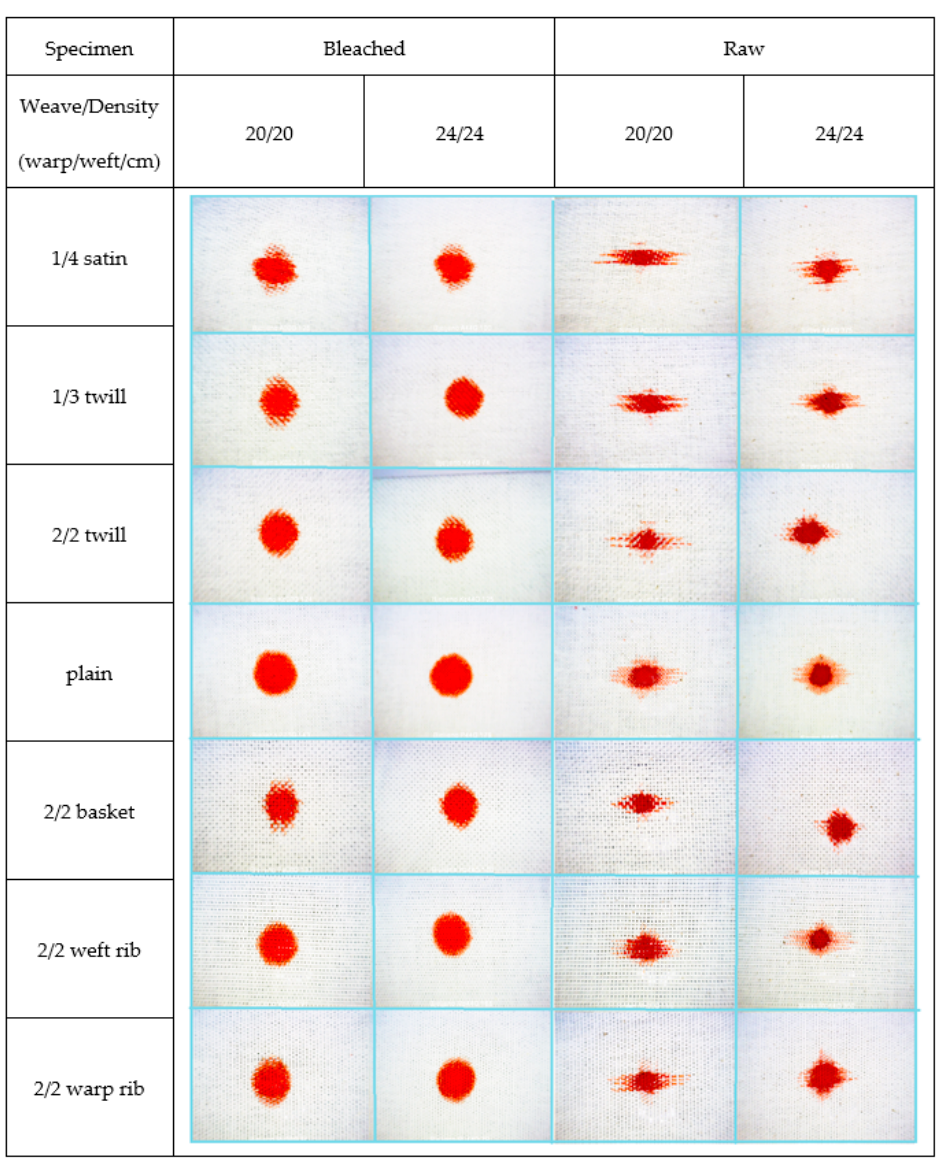
Figure 9. Images of raw and bleached specimens at the end of spreading of red dye droplets.